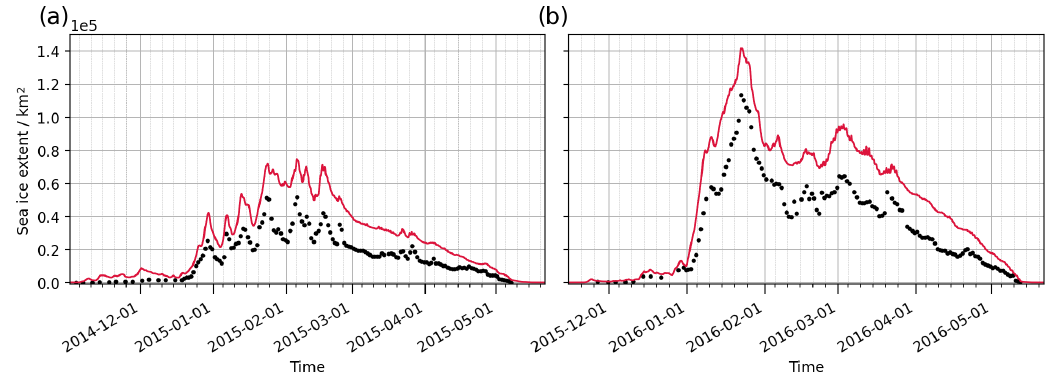
Figure 11. Time series of sea ice extent in the Baltic Sea for the two simulated winters. The red line denotes the model, and the black dots are the observations.